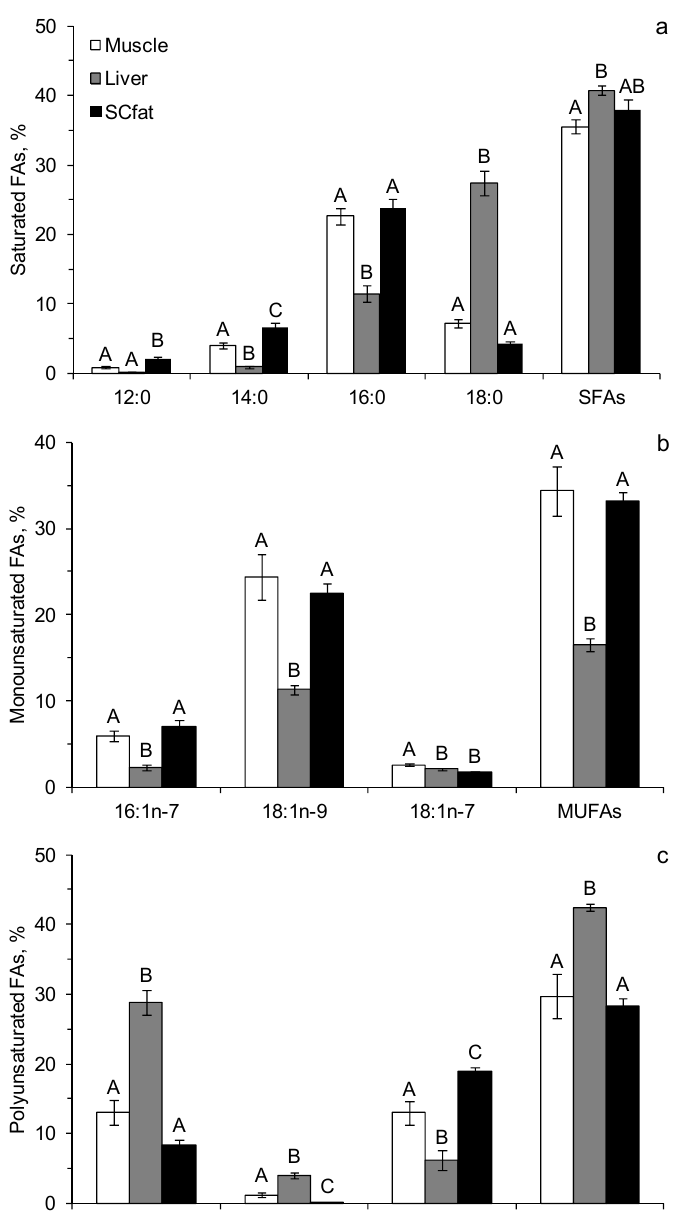
Figure 3. Contents of the prominent saturated fatty acids ( a ), monounsaturated fatty acids ( b ) and polyunsaturated fatty acids ( c ) (% of total FAs, standard error) in liver, muscle and subcutaneous adipose tissues of the Yakutian horses. Means for the same FAs labeled with the same letters are not significantly di ff erent at p < 0.05 after Tukey’s HSD post hoc